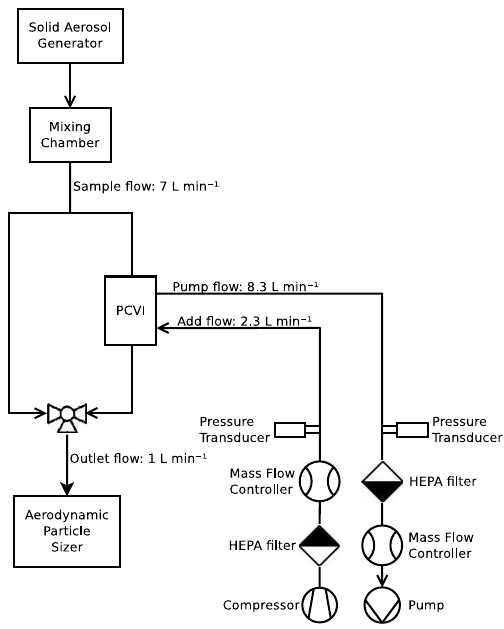
Figure 8. Schematic of the laboratory setup for the pumped coun- terflow virtual impactor (PCVI) transmission efficiency